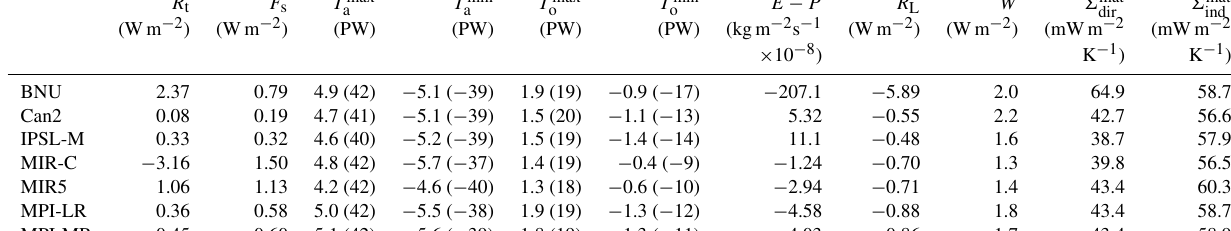
Table 2. Annual mean values of a 20-year subset of control runs from 12 models participating in CMIP5 for TOA and surface energy budgets ( B t and B s , respectively), maximal and minimal peaks of atmospheric and oceanic meridional enthalpy transports (with peak locations in latitude degrees specified in brackets) ( T max a , T min a , T max o , T min o by the Lorenz energy cycle, and material entropy production computed with the direct and indirect methods ( (cid:54) mat